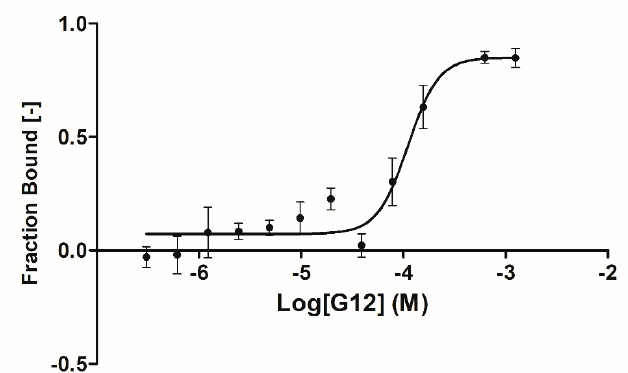
Figure 4. MST binding curve for G12 compound binding GSK-3 β . Data are the average of three experiments (error bars denote Standard Deviation (SD)). Sigmoidal fitting was performed using the Affinity Analysis software of Nanotemper Technologies.